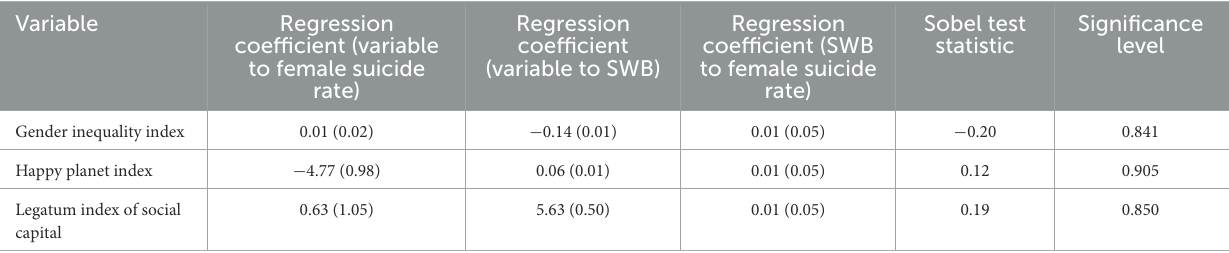
TABLE 4 Mediation analyses between social and economic indices, subjective wellbeing, and the suicide rate in women.